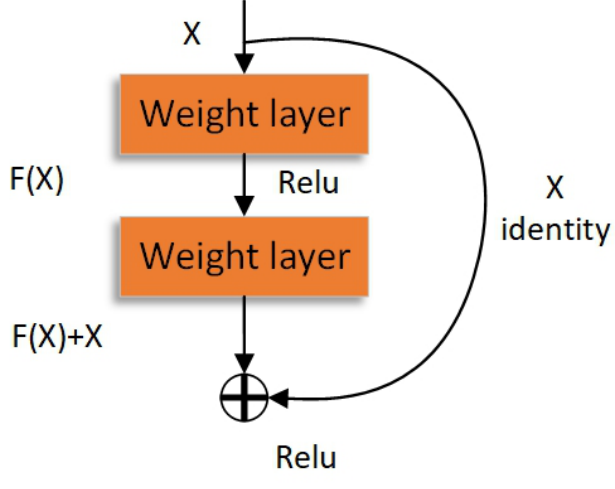
Figure 4. Structure of basic residual